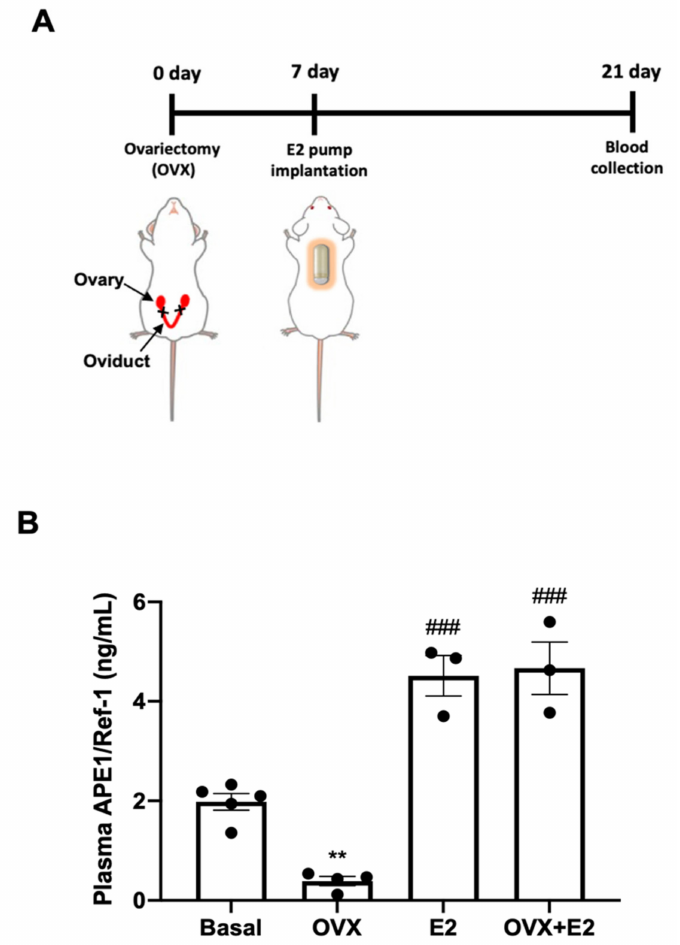
Figure 3. 17 β -Estradiol (E2) increases plasma apurinic/apyrimidinic endonuclease-1/redox factor-1 (APE1/Ref-1) levels in ovariectomized (OVX) mice. ( A ) Experimental schedule for 17 β -estradiol treatment and performing the APE1/Ref-1 assay. Ovariectomy (OVX) was performed 7 d prior to the implantation of the E2 pump in mice. APE1/Ref-1 blood levels were analyzed using an APE1/Ref-1 sandwich enzyme-linked immunosorbent assay (ELISA) 14 d after implantation of the E2 pump. ( B ) Effect of E2 implantation on plasma APE1/Ref-1 levels in ovariectomized mice. Basal group, sham OVX surgery with 10% dimethyl sulfoxide (DMSO) in the osmotic pump; OVX group, ovariectomized mice with 10% DMSO in the osmotic pump; E2 group, sham OVX surgery with E2 in the osmotic pump (10 µ g/kg/day); OVX + E2 group, ovariectomy with E2 in the osmotic pump (10 µ g/kg/day). Columns, mean (n = 3–4 animals per group.); dot plot, SE. ** p < 0.05 vs. the Basal group and ### p < 0.001 vs. the OVX group based on one-way ANOVA analysis followed by Bonferroni’s multiple comparison